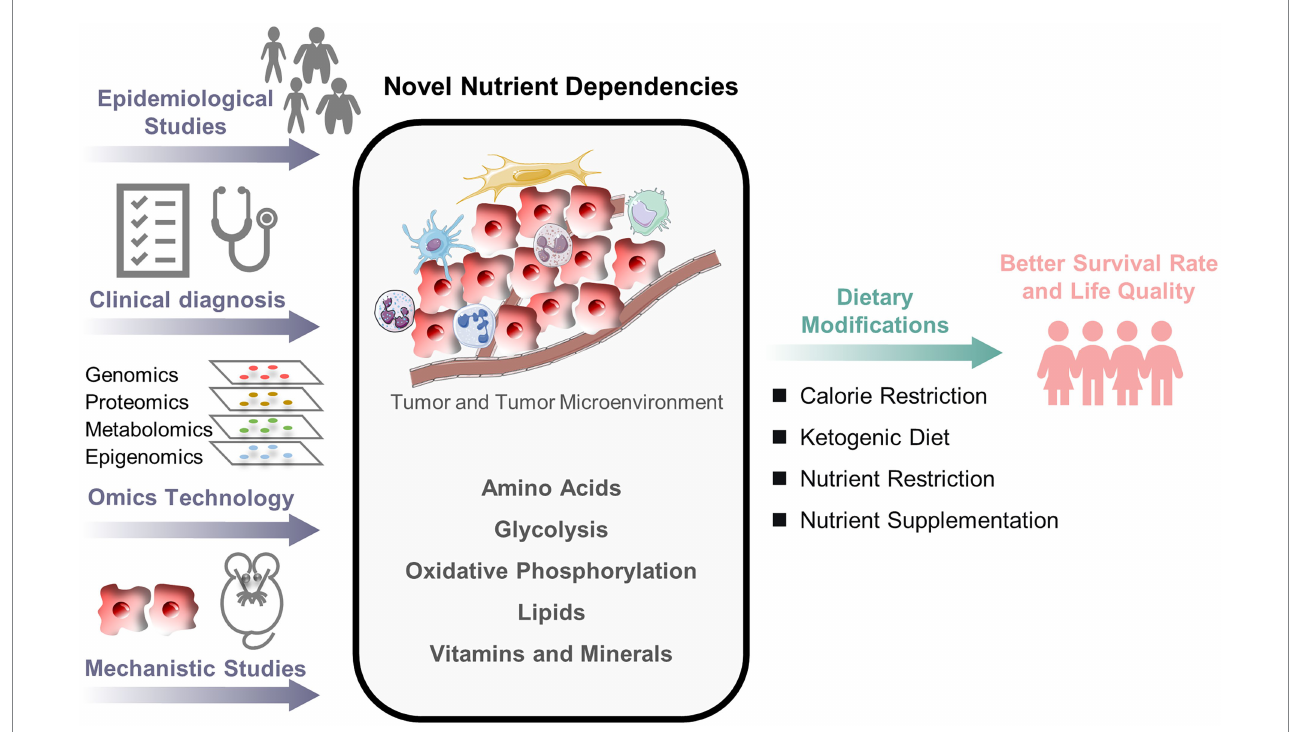
FIGURE 1 An outlook of nutritional research in pediatric cancers. The crosstalks between nutrition and pediatric cancers remain poorly understood. A combined approach of epidemiological investigation, clinical diagnosis, omics technology, and mechanistic study is necessary to understand better how nutrients alter cancer fate and to develop the optimal nutritional strategy for pediatric cancer